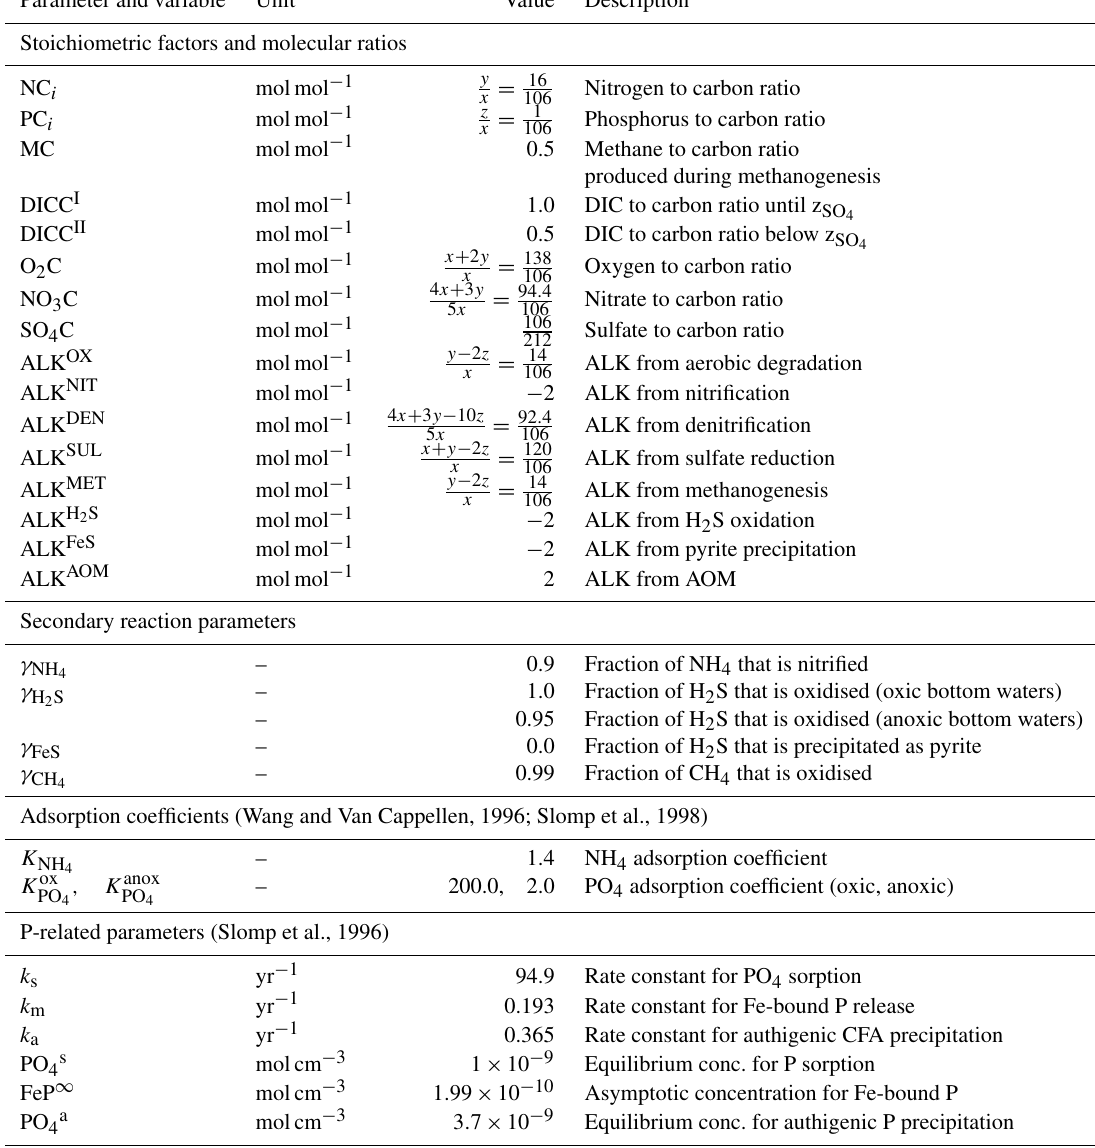
Table 10. Values for biogeochemical parameters used in OMEN-SED. The variables x , y and z denote the elemental ratio of carbon, nitrogen and phosphorus of the degrading organic matter (here set to C:N:P = 106 : 16 : 1). Parameter and